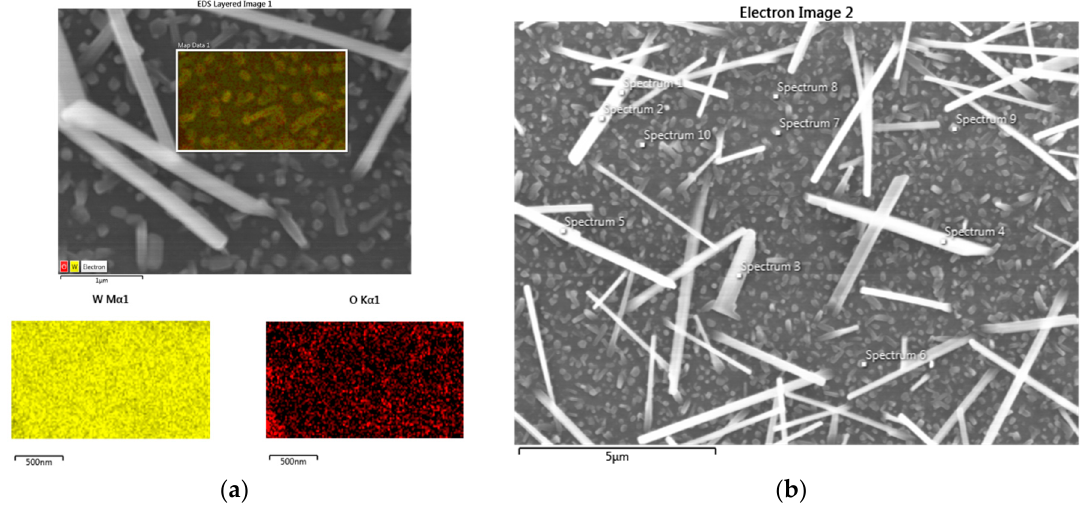
Figure 4. The image of the S1 sample annealed at 750 °C; ( a ) the EDX mapping between the nanowires, ( b ) 10 EDX points selected on the surface. Table 3. The elemental composition of the S1 sample annealed at T = 750 ◦ C, in the selected points. Table 2. The elemental composition of film surface presented in Figure 3a. Composition Element